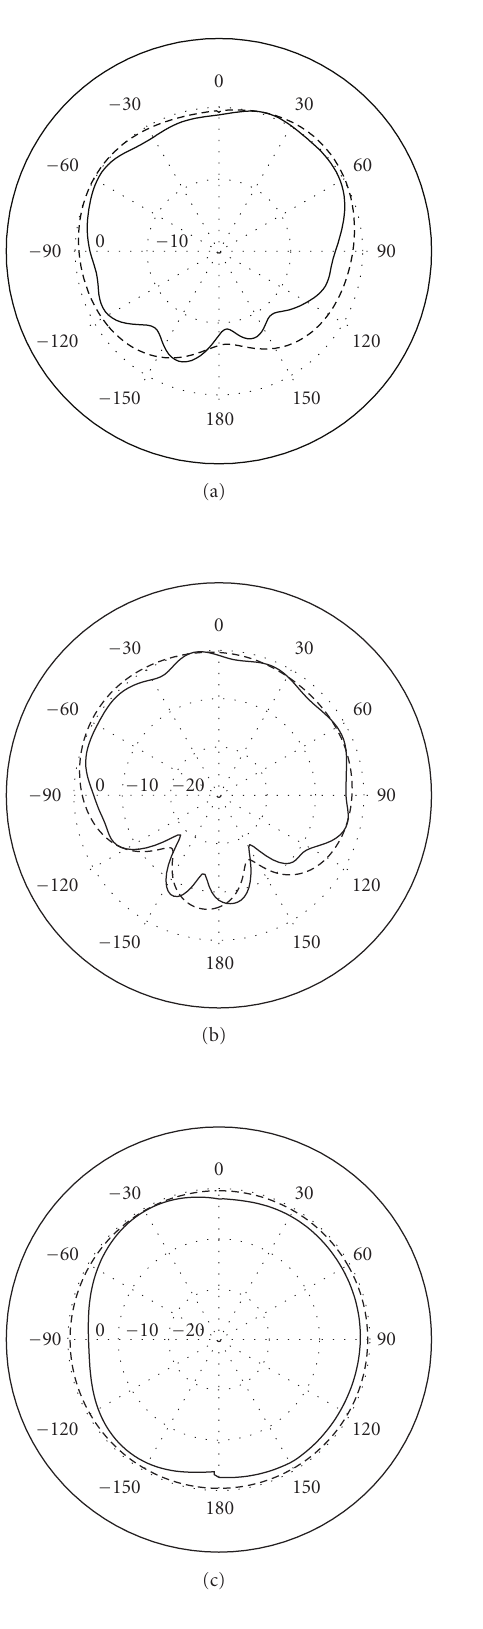
Figure 10: Measured (solid line) and simulated (dashed line) radiation patterns at 3.5GHz: (a) x - z plane, (b) y - z plane, and (c) x - y